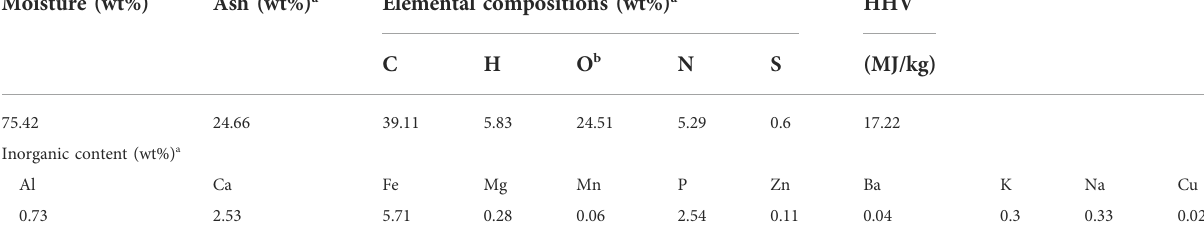
TABLE 1 Characterization of SS sample. Moisture (wt%)